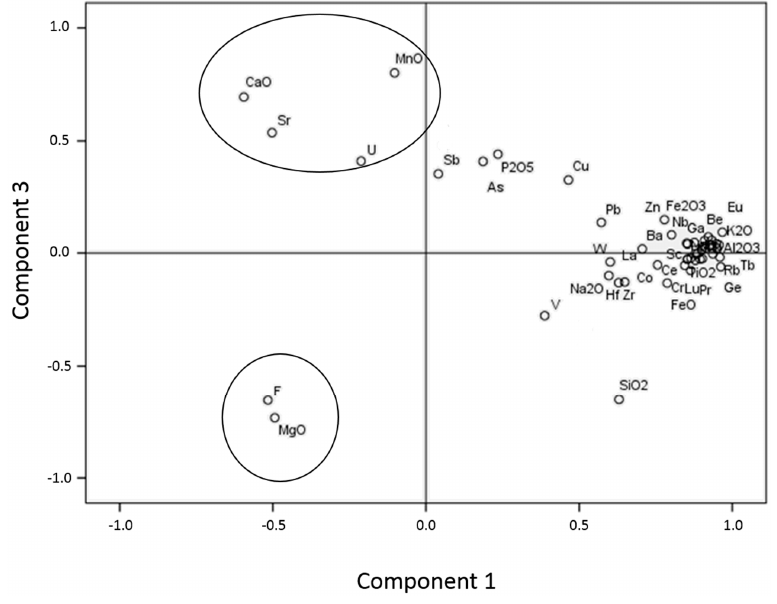
Figure 5. Principal component analysis (PCA) of the geochemical data.